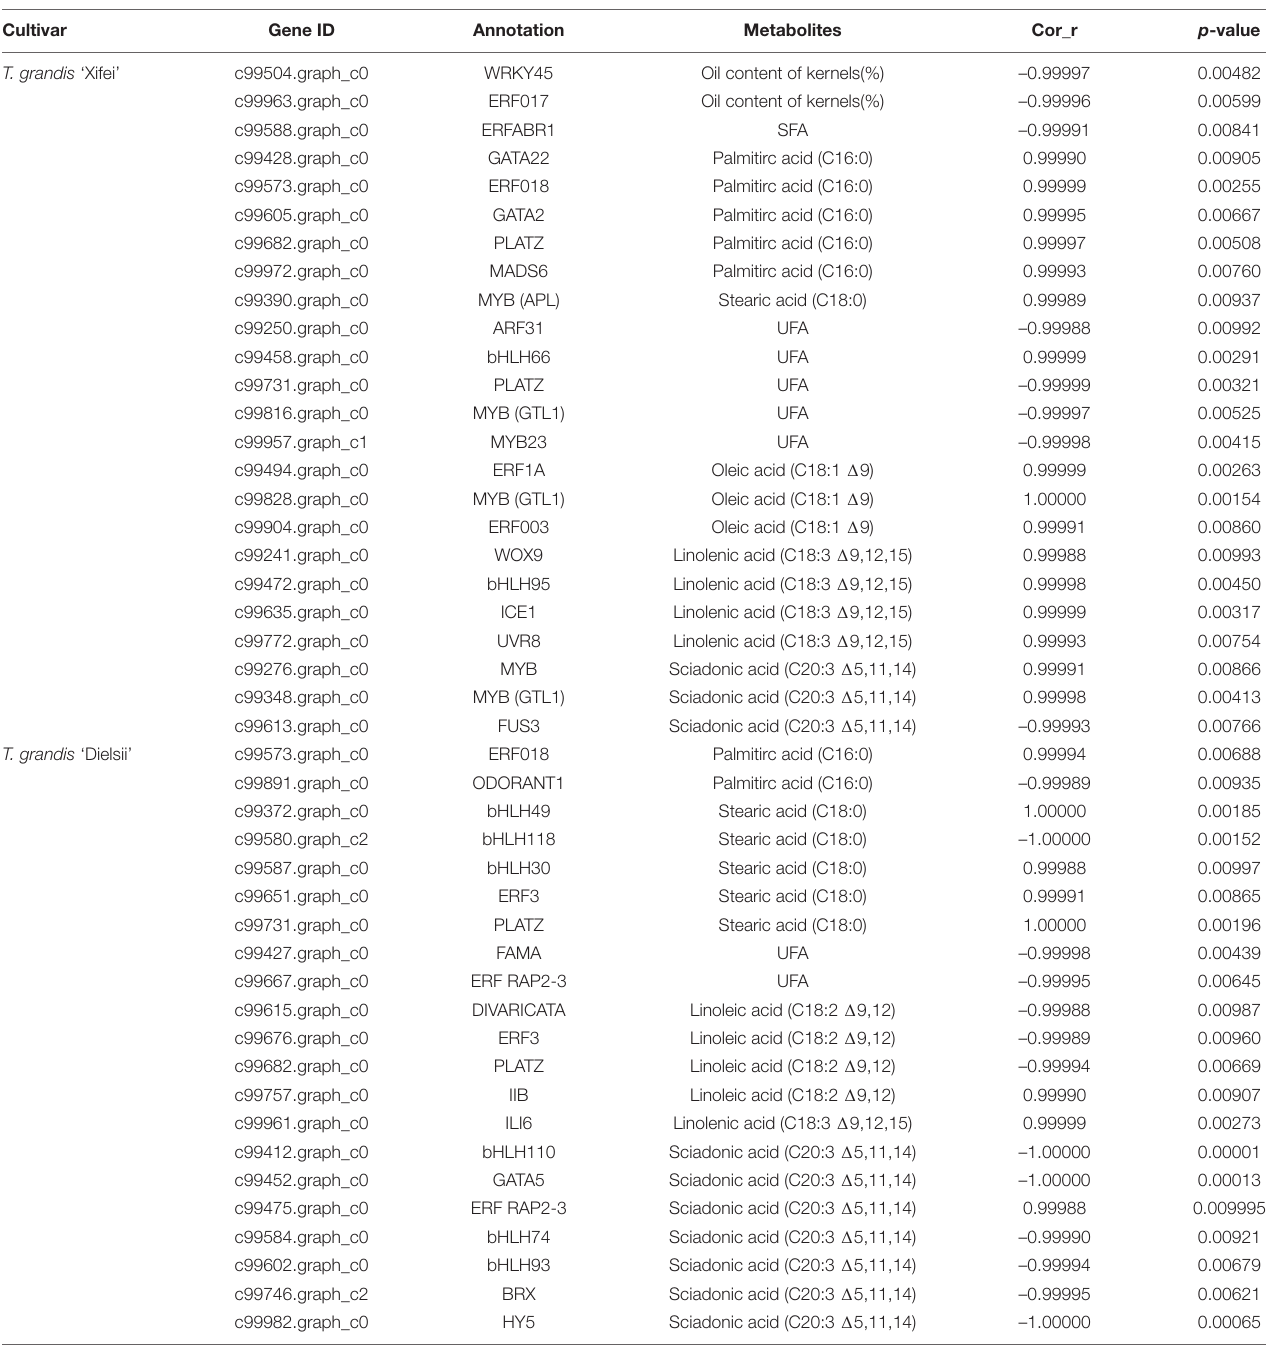
TABLE 2 | Differentially expressed transcription factors (DETFs) between cultivars and their correlation to metabolites.